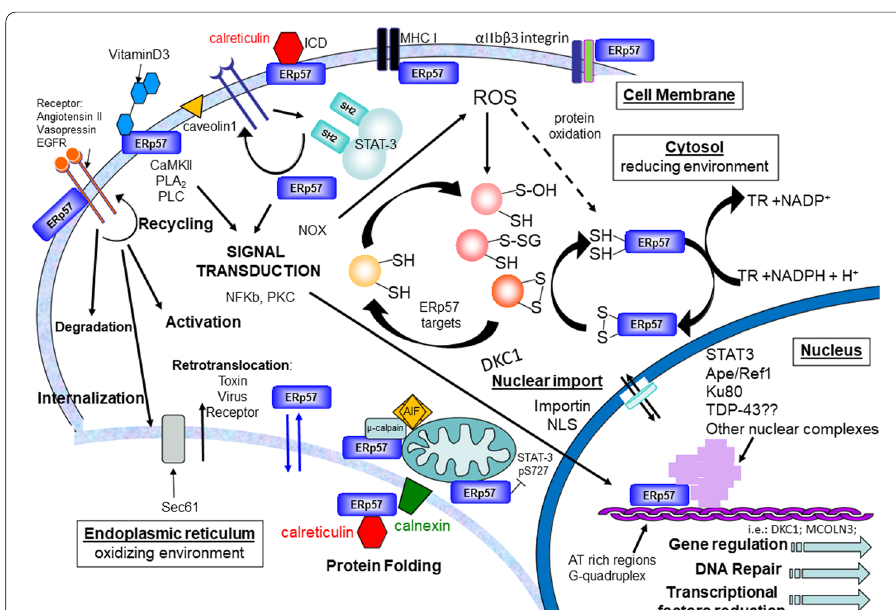
Fig. 1 Schematic representation of the different roles of ERp57 / PDIA3 in cellular processes in different cell compartments. Cell membrane: ERp57/PDIA3 participates in assembling of MHC I, interacts with different receptors (e.g., angiotensin II, vasopressin, and EGF receptors), acts as receptor of vitamin D 3 , participates in ICD in complex with calreticulin, and interacts with αIIbβ3 integrin in platelet cells. ERp57/PDIA3 participates in different cellular processes, including signal transduction, recycling, degradation, and internalization. Cytosol: ERp57/PDIA3 interacts with STAT3 and contributes to redox balance acting on thioredoxin (TR) and other targets. Nucleus: ERp57/PDIA3 interacts with different proteins (e.g., STAT3; Ape/Ref1, Ku80, and maybe TDP-43) and different DNA sequences (AT-rich regions) or structures (G-quadruplex). ERp57/PDIA3 participates in gene expression (e.g., DKC1; MCOLN3), DNA repair, and transcriptional factor reduction. Endoplasmic reticulum: ERp57/PDIA3 promotes oxidative folding of glycoproteins in concert with lectin chaperones calnexin and calreticulin and is involved in retrotranslocation to cytosol of toxin, virus, and receptor. ER–mitochondrion: ERp57/PDIA3 is present in mitochondria-associated membranes (MAM), the regions of ER that are closely associated with mitochondria; ERp57/PDIA3 complexed with μ-calpain is able to cleave apoptosis-inducing factor (AIF) and interferes with the mitochondrial bioenergetic function via the inhibition of STAT3 Ser727